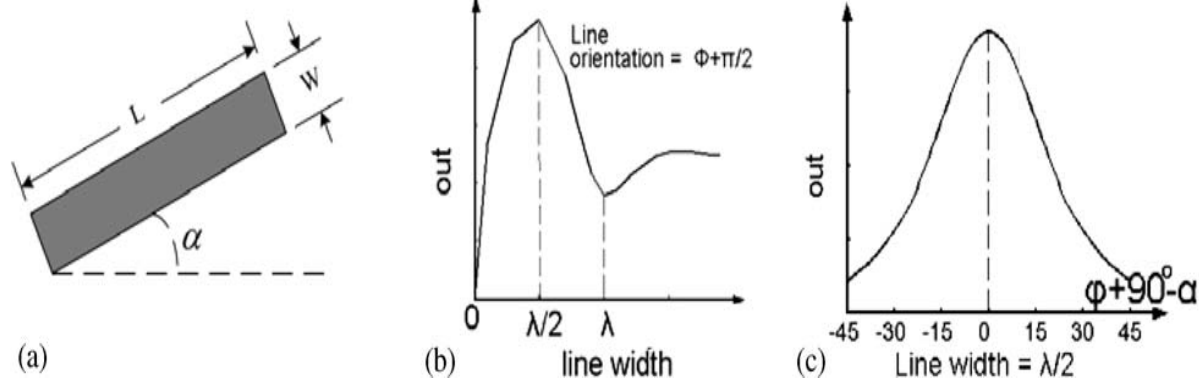
Figure 7. Length and width described in the above figure: ( a ) Gabor filter outputs changed concerning the width and orientations ( b , c ), implying Gabor filter selectivity of line width and orientation [17].